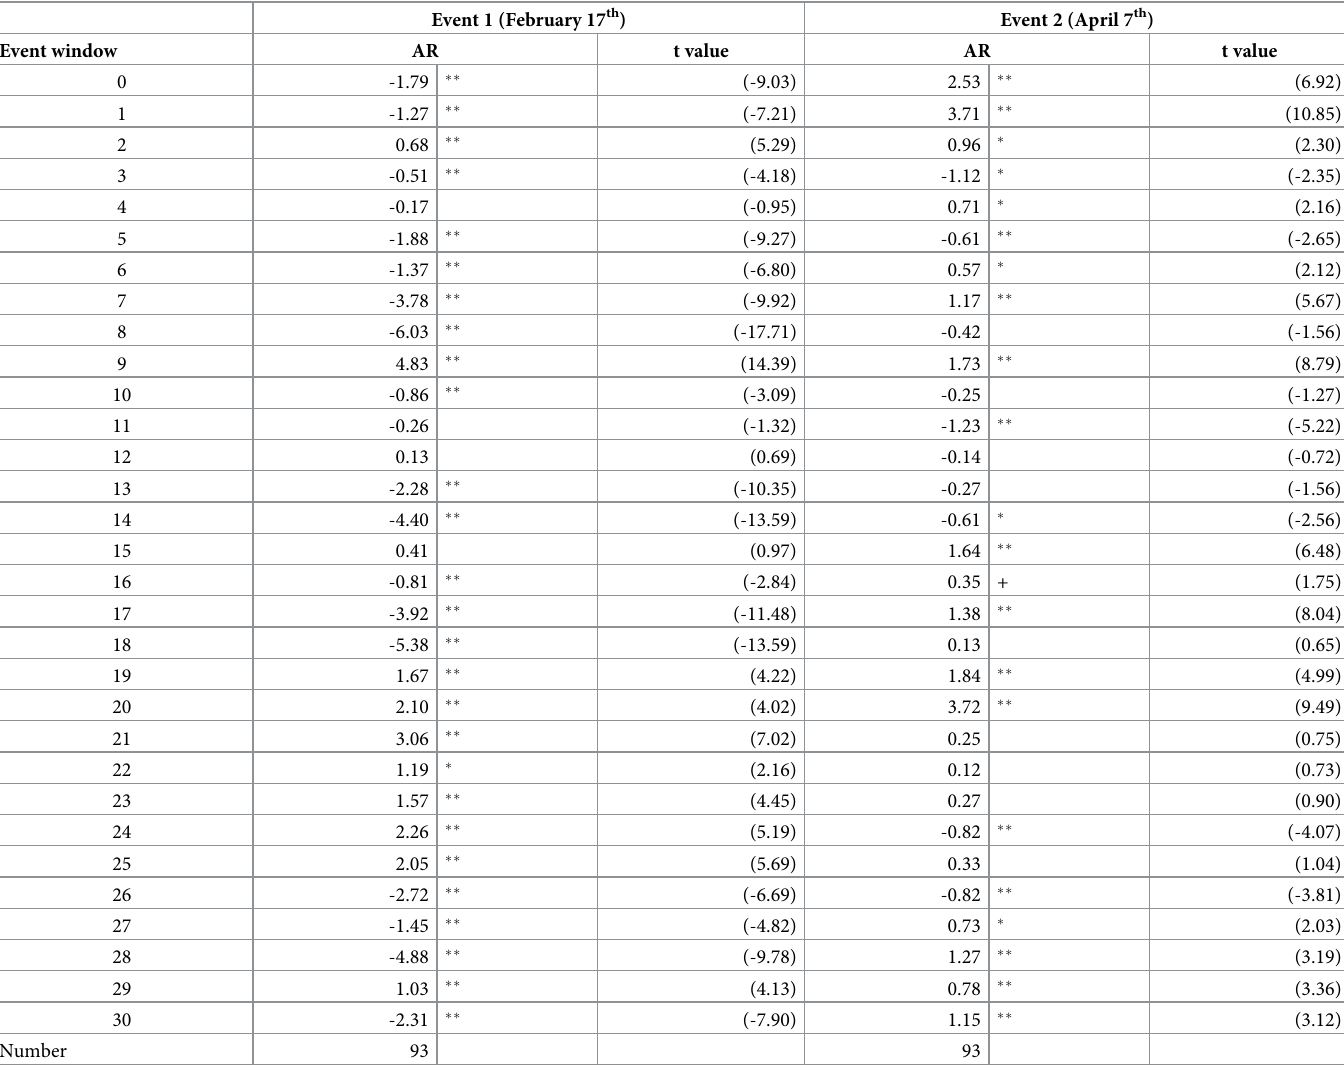
Table 1. Results of